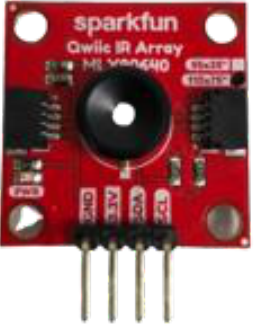
Figure 18. Thermal camera